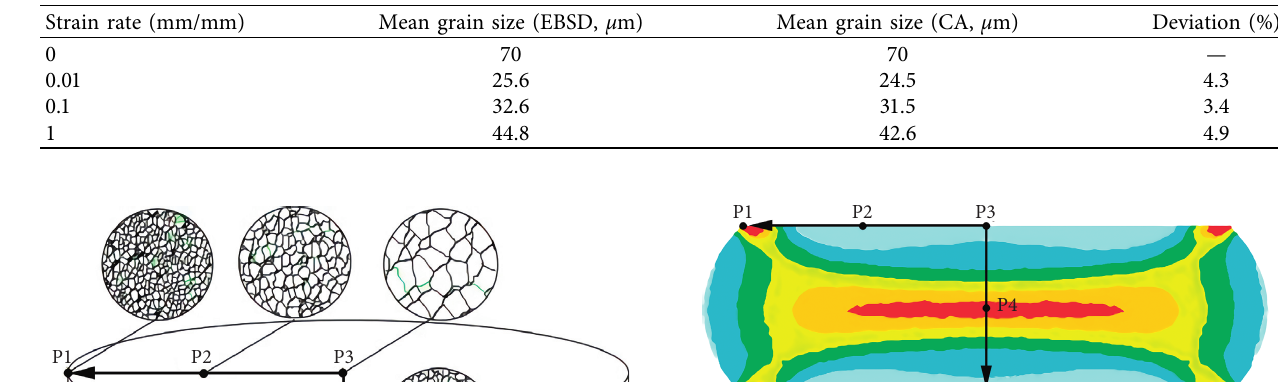
Table 3: The mean grain size from EBSD and CA simulation.